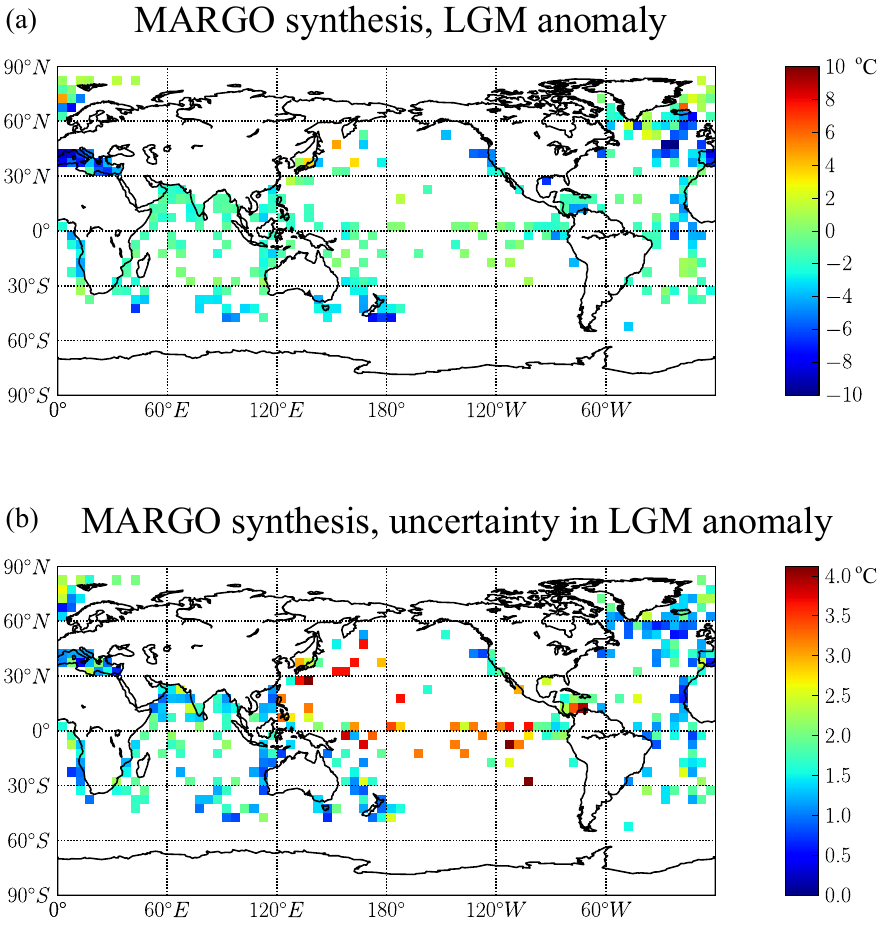
Fig. 1. (a) MARGO LGM SST anomaly with respect to WOA data. For ease of comprehension, zero is place at the centre of the colour bar, giving a range of − 10 ◦ C to +10 ◦ C. The minimum value is actually − 11.8 ◦ C and the maximum 6.32 ◦ C. (b) The value of the uncertainty on the annual mean included in the MARGO synthesis